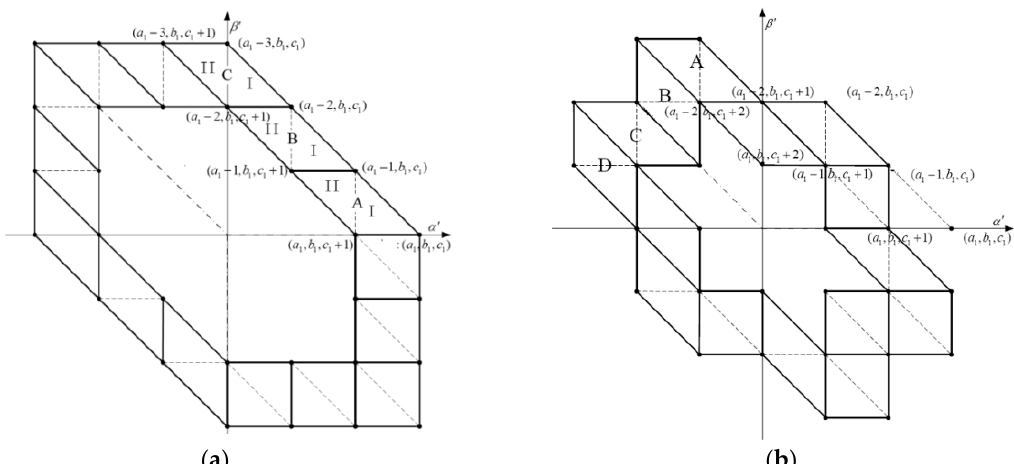
Figure 21. Switching paths for 5-level inverter in the outermost layer, ( a ) the first class switching path, ( b ) the second class switching path.